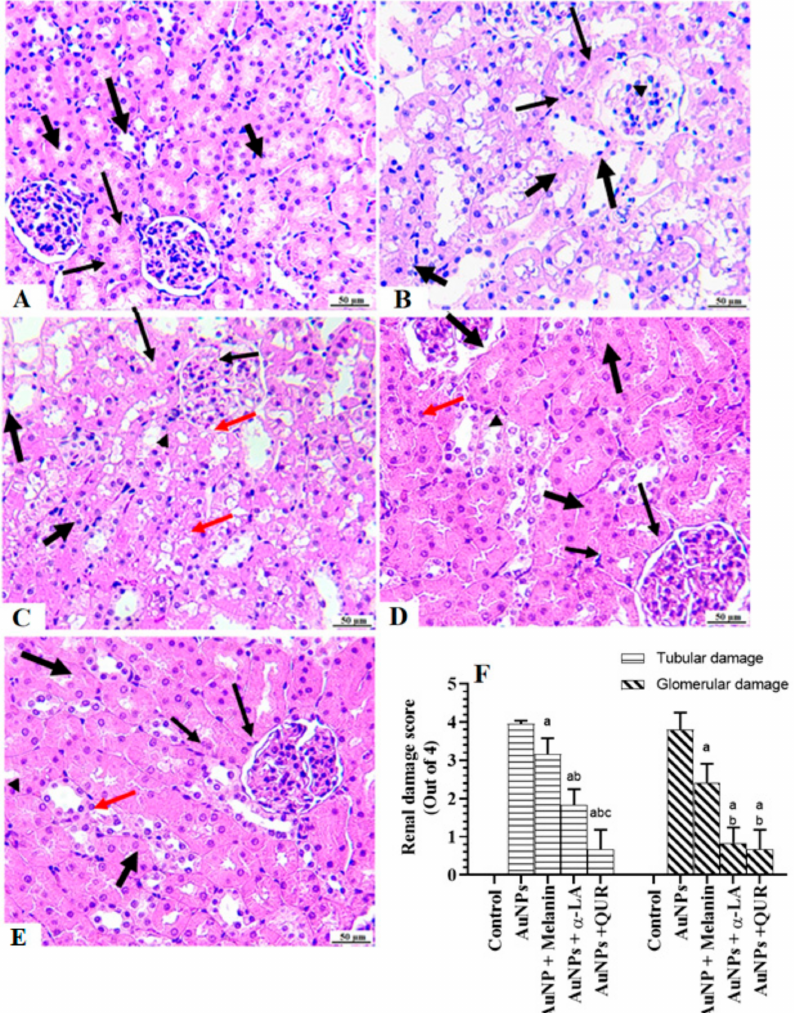
Figure 3. Histological sections from all groups as stained by hematoxylin and eosin: ( A ) Kidney sample taken from a control rat, showing an intact glomerulus (long thin arrow) with a normal- appearing glomerular space (short thin arrow). (long thick arrow) and distal convoluted tubules